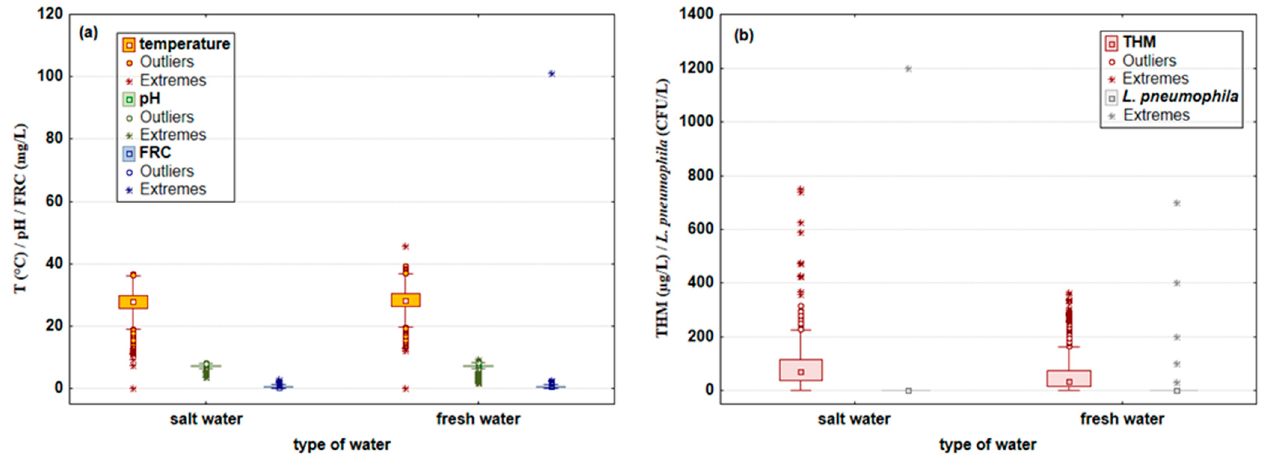
Figure 2. Water physicochemical parameters: ( a ) temperature (°C), pH, and free residual chlorine (FRC; mg/L), and ( b ) trihalomethanes (THM; µ g/L) and amount of Legionella pneumophila (CFU/L) in children’s, recreational, hot tubs, and sports/Olympic swimming pools. Results are shown as median, minimum, and maximum values with outliers and extreme values (N pool data = 4587; N children’s data = 495; N recreational data = 2833; N hot tubs data = 966; N sport/Olympic data = 293).